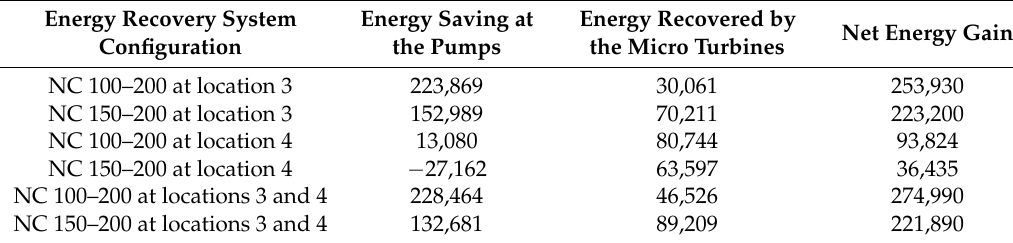
Table 2. Energy budgets (kWh/y) for the candidate energy recovery system configurations in the pump-driven